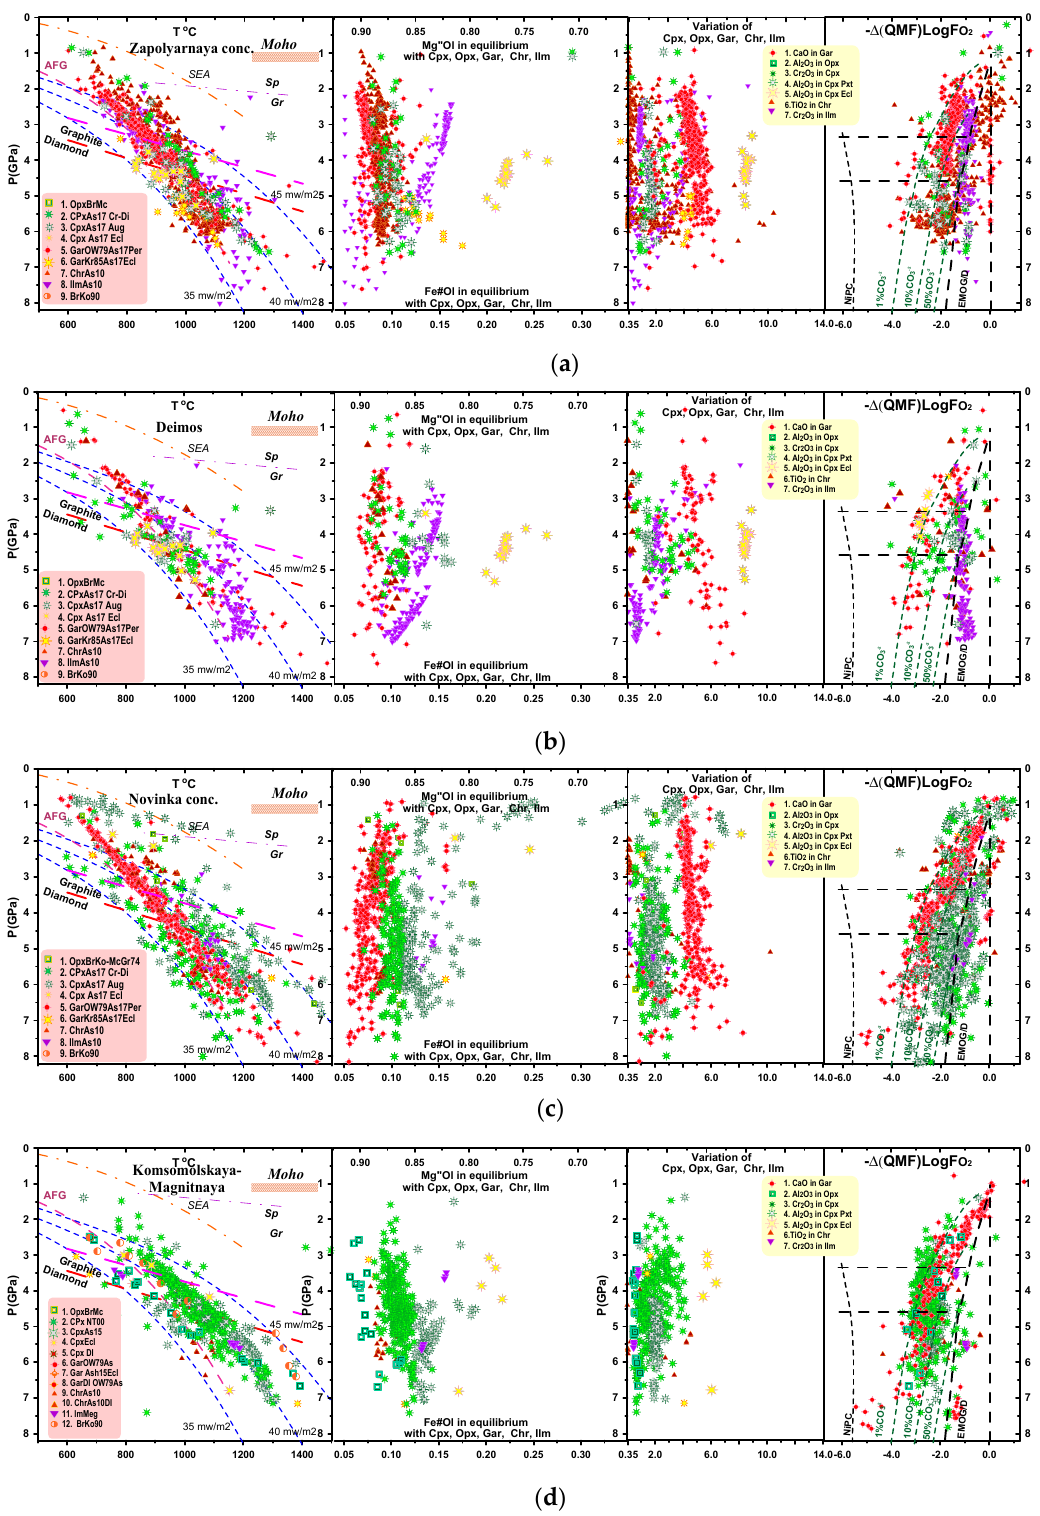
Figure 14. P-T-X-fO 2 diagram for the concentrate from ( a ) Zapolyarnaya pipe. ( b ) Deimos pipe. ( c ) Novinka pipe. ( d ) Komsomolskaya-Magnitnaya pipe. The symbols are the same as for Figure 10.